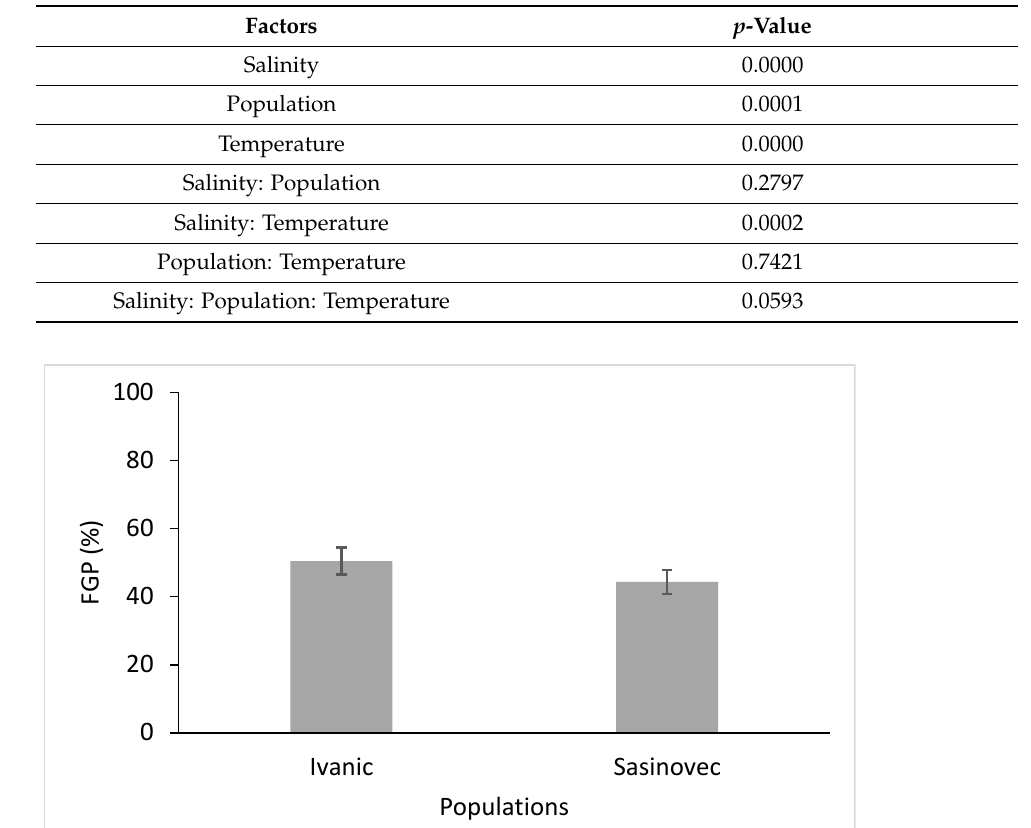
Figure 1. Final germination percentages (FGP) of D. stramonium at different temperature ranges and salinity levels (data from the two populations were averaged). Vertical bars represent the standard errors. Table 1. The effects of salinity, population, and temperature, and their interactions on the final germination percentage of D. stramonium .